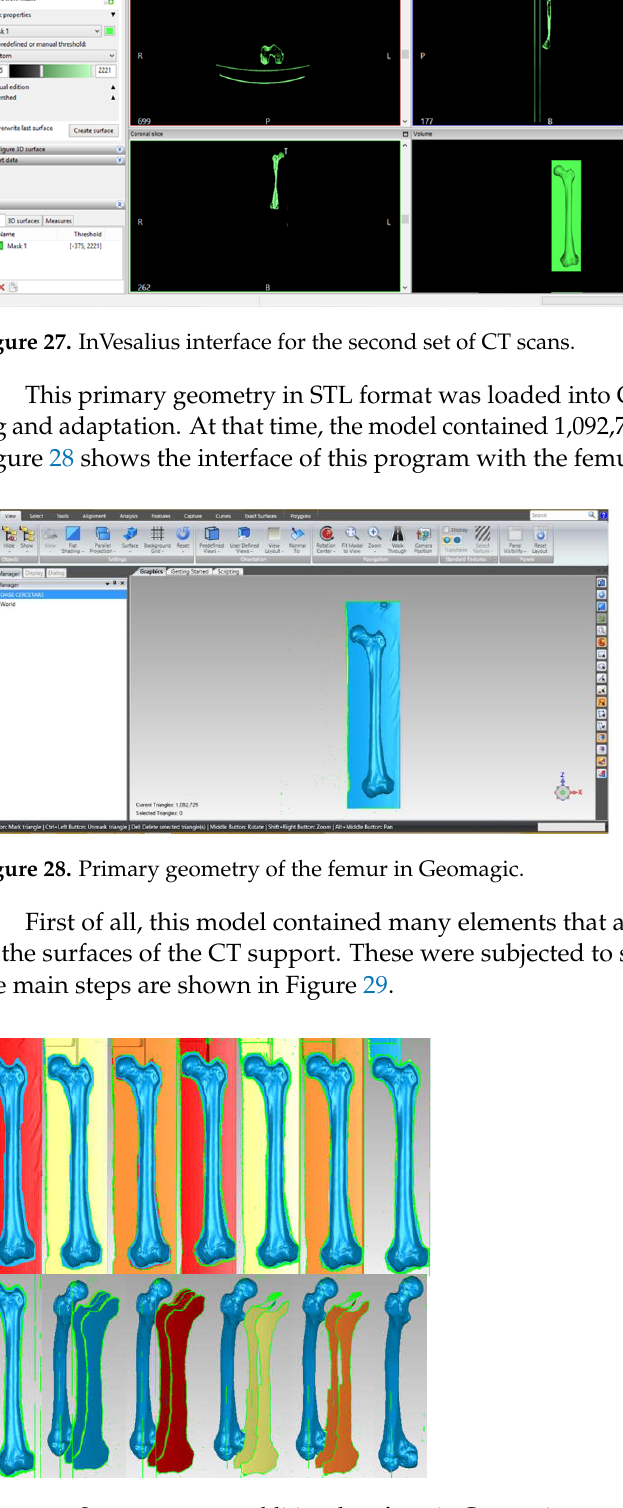
Figure 30. The model of the femur first in Geomagic, then in SolidWorks. The virtual bone models were loaded into the Assembly module of SolidWorks. Based on anatomical data, these components were positioned and attached to each other using CAD techniques. Previously, the femur model was scaled and adapted to the other bone components. Additionally, the pubic symphysis was created using different anatom- ical data. Figure 31 shows the final model of the intact hip joint. Figure 31. Final geometry of the intact hip joint in SolidWorks.